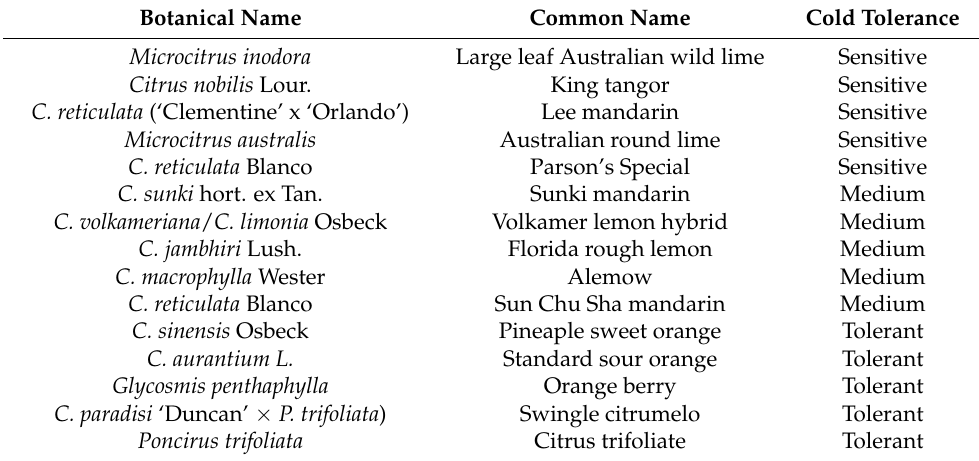
Figure 1. Damaged shoots of Citrus macrophylla ( a ) and Carrizo citrange ( b ) seedlings grafted with the Valencia delta seedless variety exposed to 0 ◦ C for 30 days. Table 1. Citrus cold-tolerant/-sensitive varieties to cold stress